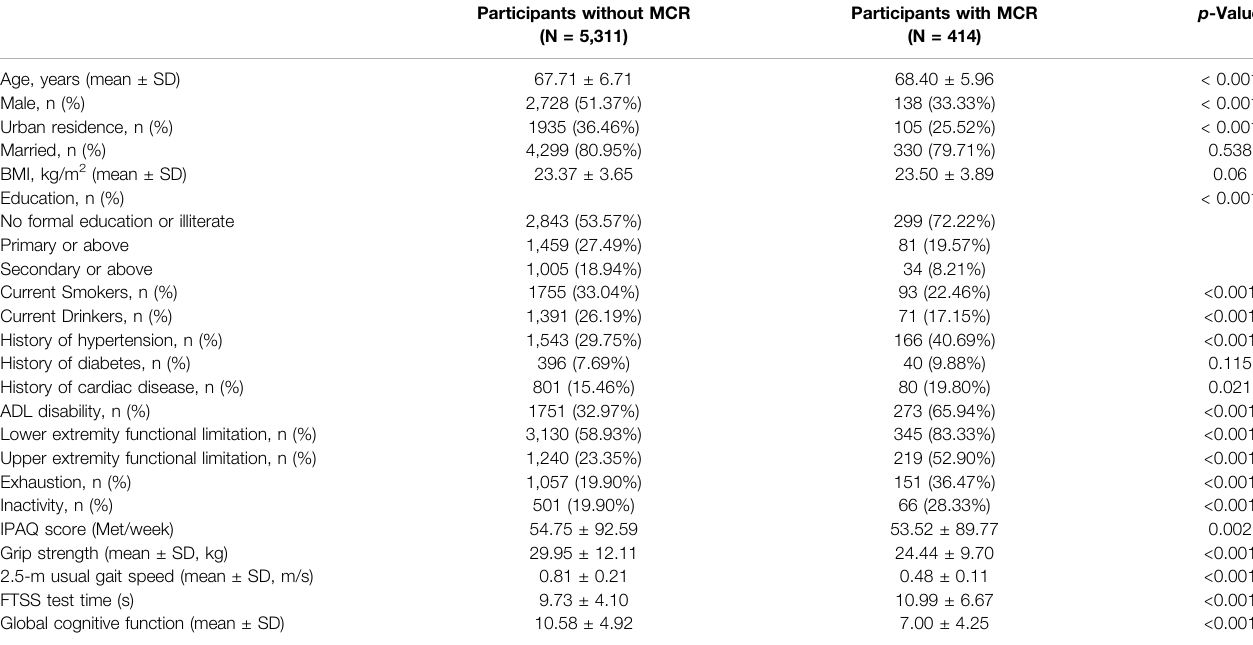
TABLE 1 | Characteristics and comparing between